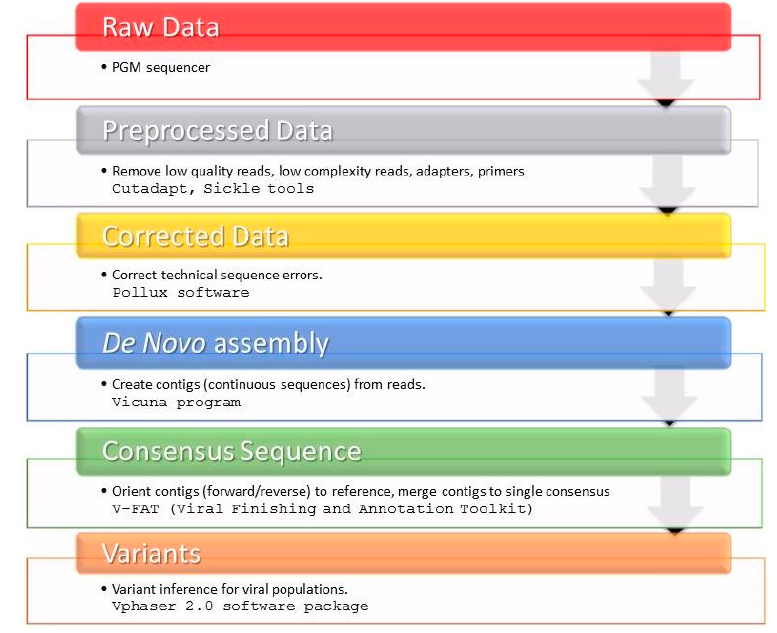
Figure 3. Workflow of sample-specific consensus sequence of the NS3 region generated by an in-house-developed script.